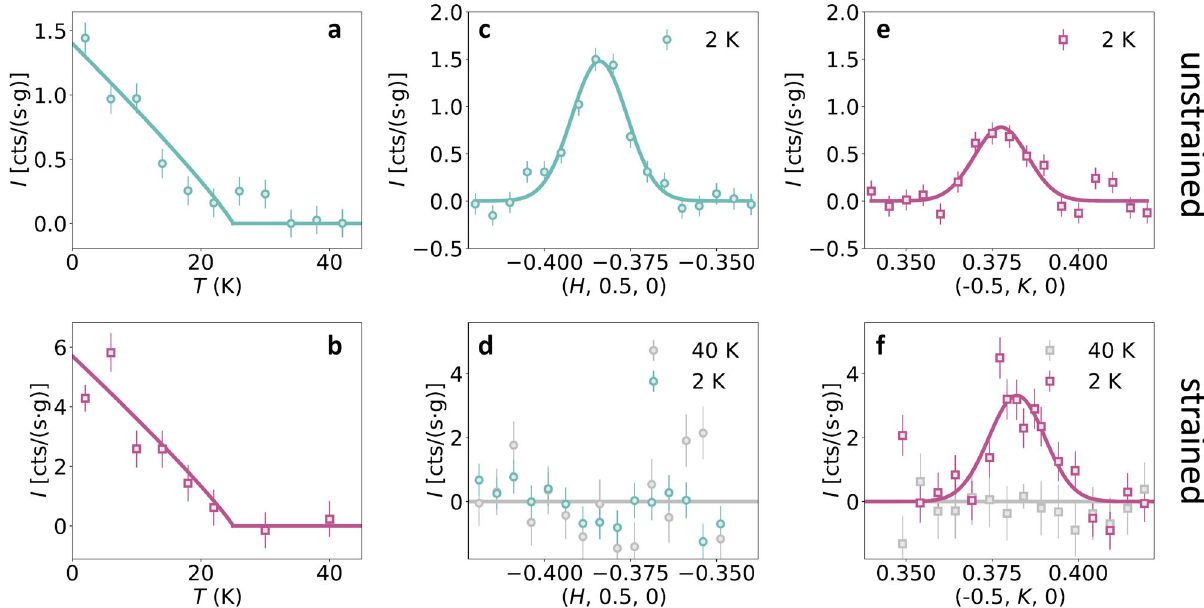
Fig. 4 Strain-induced spin-density wave domain repopulation. Background-subtracted neutron scattering results comparing the scattering from the unstrained and strained sample. The error bars are dictated by Poisson statistics and obtained via Gaussian error propagation. Panels a and b show the temperature dependence of the magnetic Bragg peak intensities at Q a and Q b for the unstrained and strained sample, respectively. The solid lines are SDW SDW guides to the eye. Panels c and d display the reciprocal space scans of La 1 : 88 Sr 0 : 12 CuO 4 around Q a at ambient conditions and under compressive a -axis SDW strain. In panels e and f we plot the analogous scans around Q b . Their comparison shows that uniaxial pressure along the La 1 : 88 Sr 0 : 12 CuO 4 copper- SDW oxygen bond direction leads to a repopulation of the SDW domains, in which the magnetic domain perpendicular to the pressing direction is